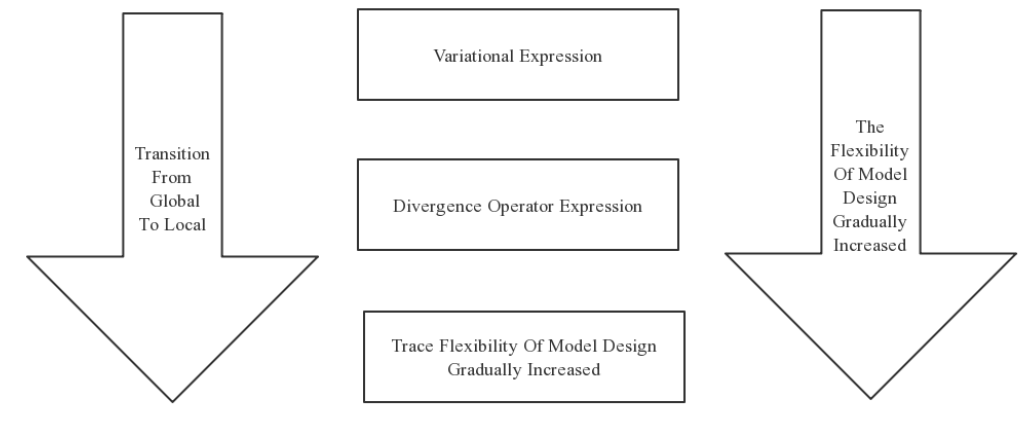
Fig. 1 Hierarchical relationship analysis diagram.